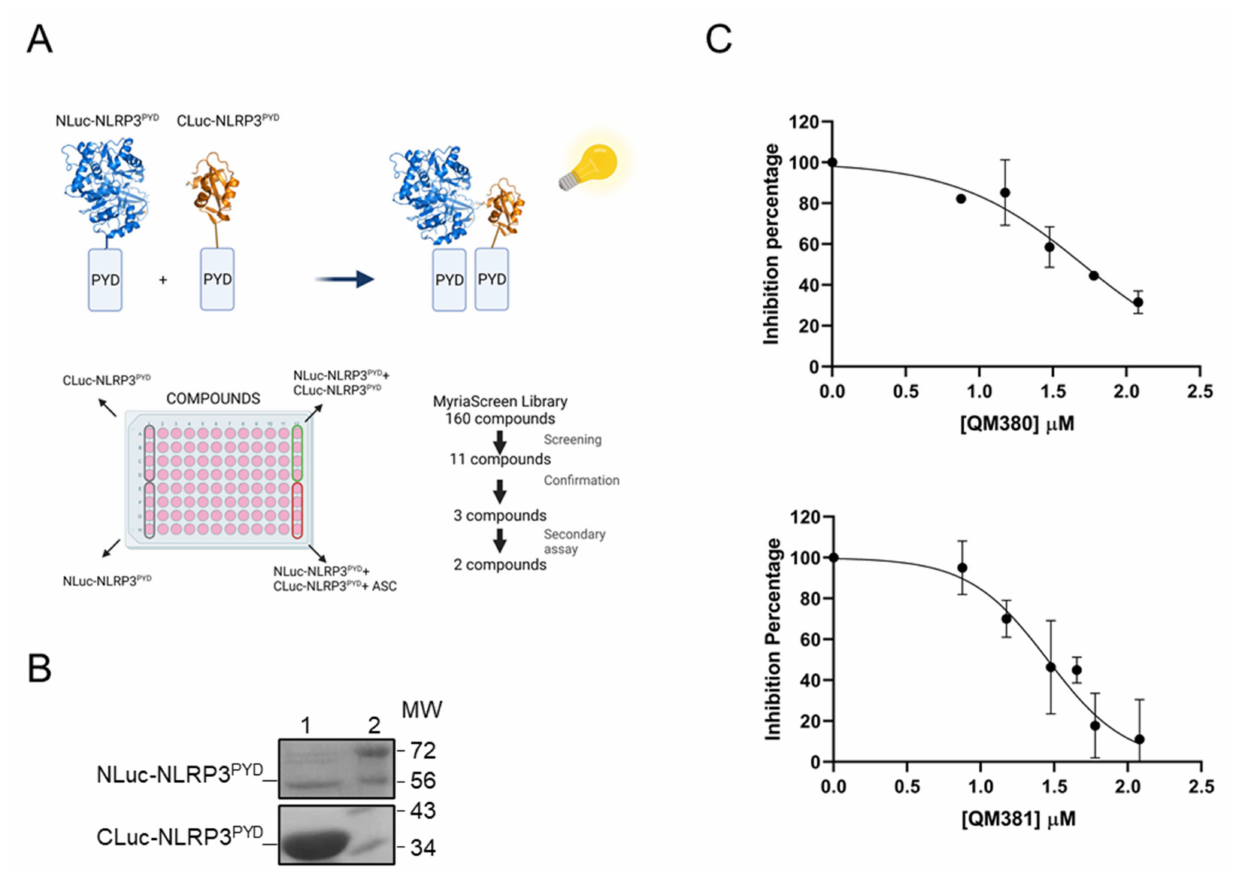
Figure 1. QM380 and QM381 inhibit NLRP3 PYD homo-oligomerization in vitro: ( A ) Flow chart describing the screening of a set of small molecules from the Myria Screen library. The first four wells of the first column of each plate were filled with CLuc-NLRP3 PYD , and the last four wells were filled with NLuc-NLRP3 PYD without any compound treatment. The first four wells of the last column were used as positive controls filled with the mixture of chimeric proteins without any compound treatment, while the last four wells were considered as negative controls. ( B ) SDS-PAGE of purified N-Luc NLRP3 PYD and C-Luc NLRP3 PYD proteins. Lanes 1 in the top and bottom boxes show the purified Nluc-NLRP3 PYD and Cluc-NLRP3 PYD , respectively, and Lanes 2 show the molecular weight marker (MW). ( C ) QM380 and QM381 inhibit NLRP3 PYD homo-oligomerization in a concentration- dependent manner. Compounds were incubated in the presence of CLuc-NLRP3 PYD at different concentrations for 15 min, and NLuc-NLRP3 PYD was then added. Luminescence was measured as described in the methods section. Luminescence data were normalized to the positive control in the absence of the compound and is expressed as the mean ± SD of n = 2 and n = 4 independent experiments for QM380 and QM381,